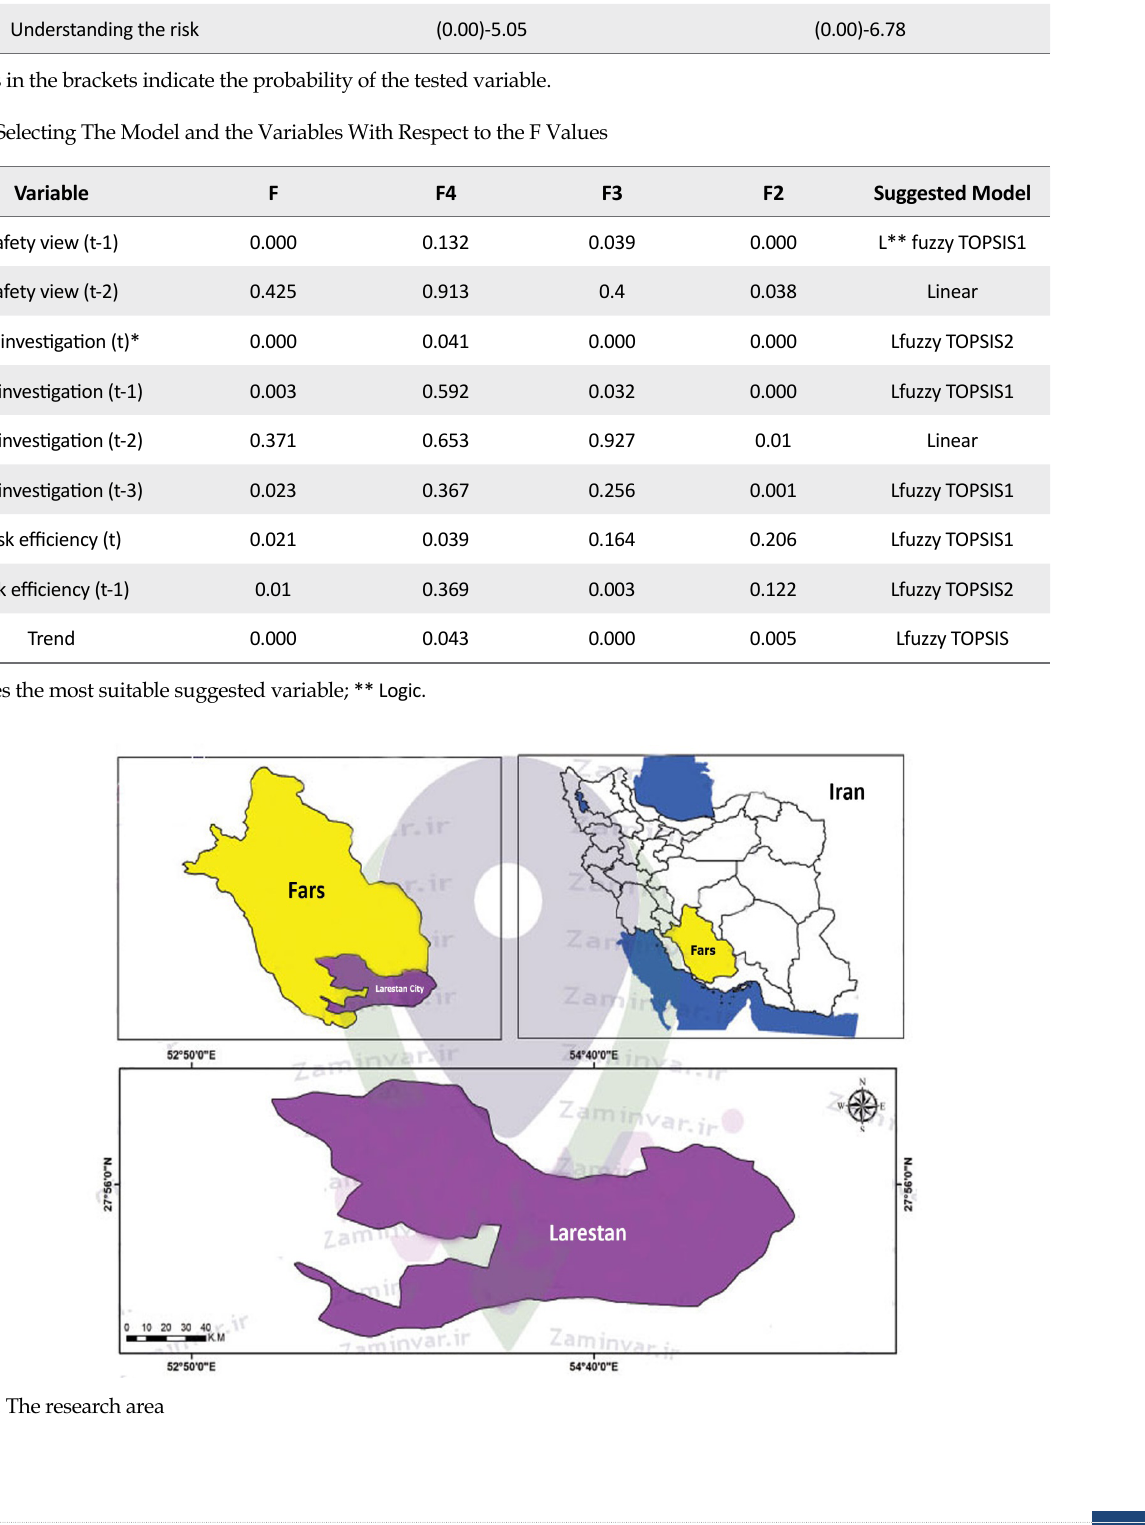
Sekhavati E & Jalilzadeh Yengejeh R. Investigation and Optimization of Air Pollution Risk by a Multi-criteria Decision Making Method. J Adv Environ Health Res. 2021;